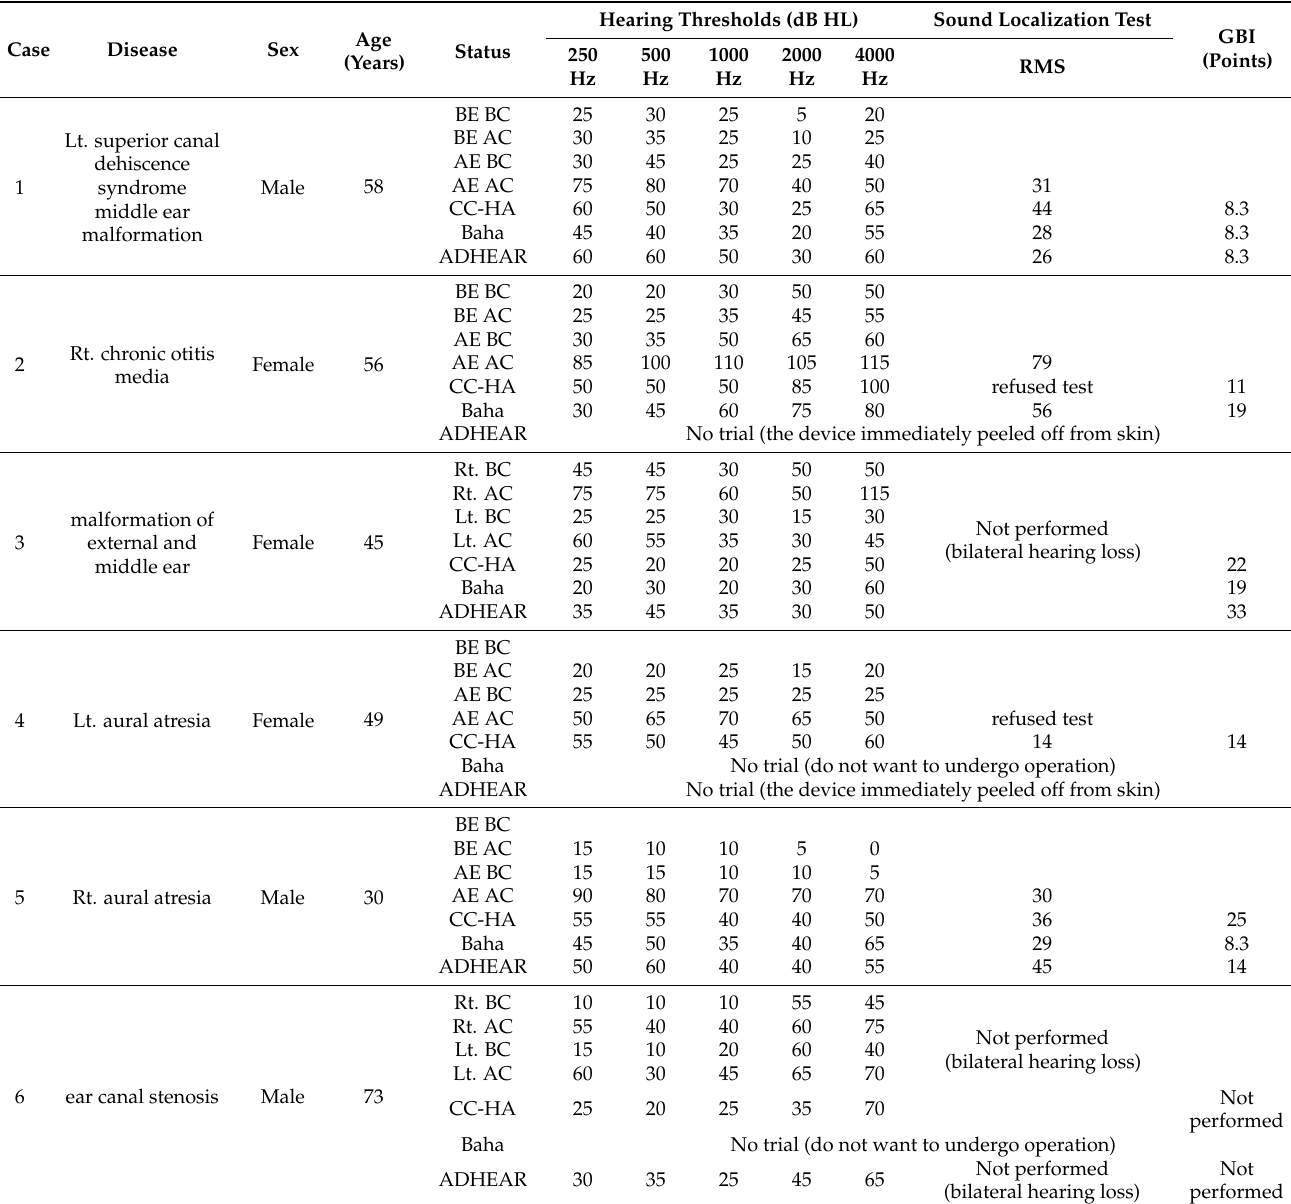
Table 1. Results of the comparative trials of CC-HA, Baha and ADHEAR in each